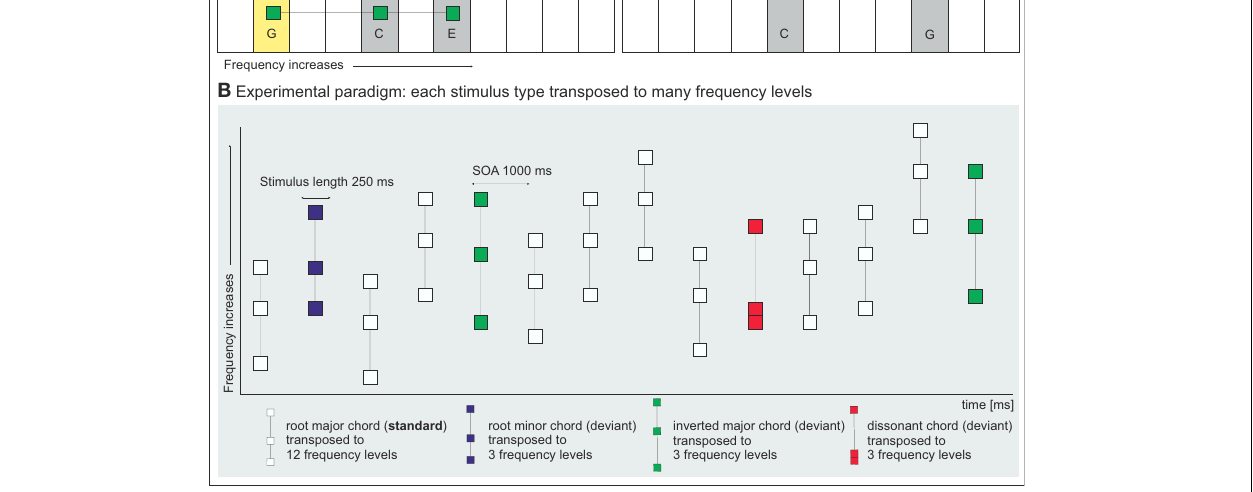
sequence with root major chords (white) as standards and root minor chords (blue), inverted major chords (green) and dissonant chords (red) as deviants, each transposed to various frequency